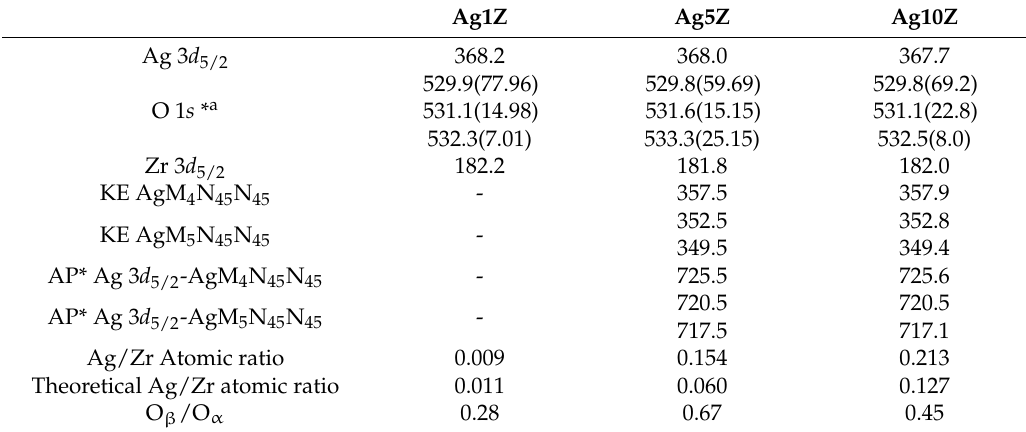
Figure 7. ( A ) Ag 3d XPS spectra, ( B ) AgMNN Auger transition spectra, and ( C ) O1s XPS spectra of the different studied catalysts. Table 2. XPS BE (eV) values for the Ag3d, O1s, and Zr3d, Auger parameters, Ag/Zr atomic ratios, and oxygen species ratio for the studied catalysts.